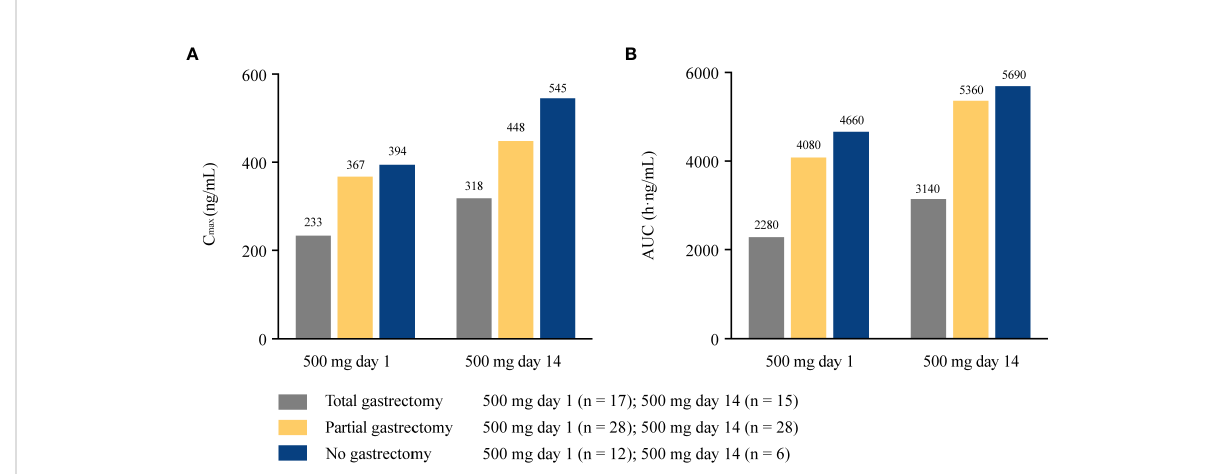
FIGURE 2 Pharmacokinetic parameters of apatinib in patients with different extent of gastrectomy at 500 mg day 1 and 500 mg day 14. (A) C max at 500 mg day 1 and 500 mg day 14; (B) AUC 24 at 500 mg day 1 and AUC ss at 500 mg day 14. C max , maximum plasma concentration; AUC 24 , area under the plasma concentration-time curve from time 0 to 24 h; AUC ss , areas under the plasma concentration-time curve at steady